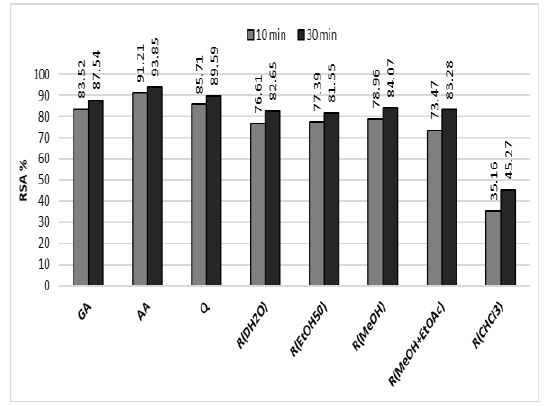
Figure 7.RSA% of standards and studied extracts after 10 and 30 min Statistical analysis significant differences between